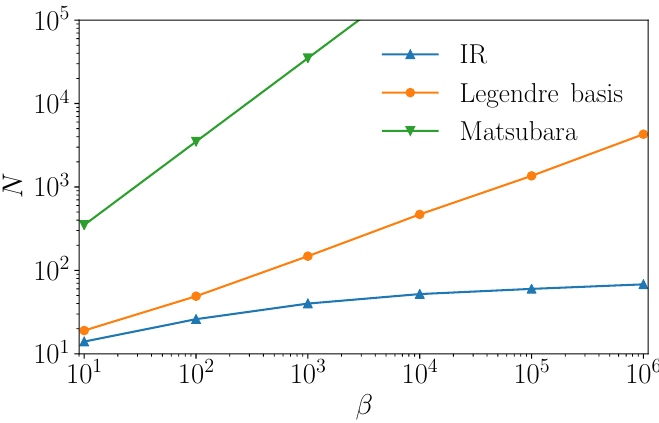
Figure 3: β –dependence of the number of basis functions, N , needed to reconstruct the Green’s function with a high accuracy. We used the same spectral function as in Fig. 2(b). We counted the minimum number of basis functions required to represent G ( τ = 0 ) with an accuracy of 10 − 8 . For the the imaginary-frequency representation, we count the number of nonnegative imaginary frequencies. A second-order high- frequency expansion is applied in the Fourier transform into G ( τ )